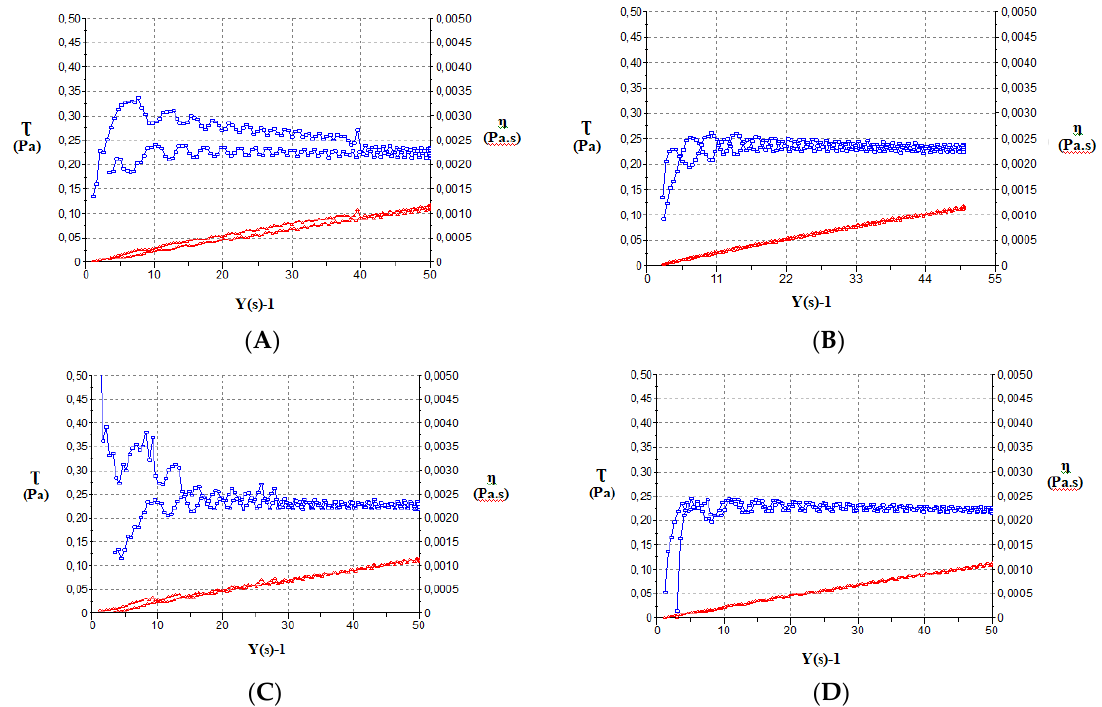
Figure 5. Rheological behavior of NLCs-F3 ( A ); NLCs-F9 ( B ); NLCs-F3-L ( C ); NLCs-F9-L ( D ).